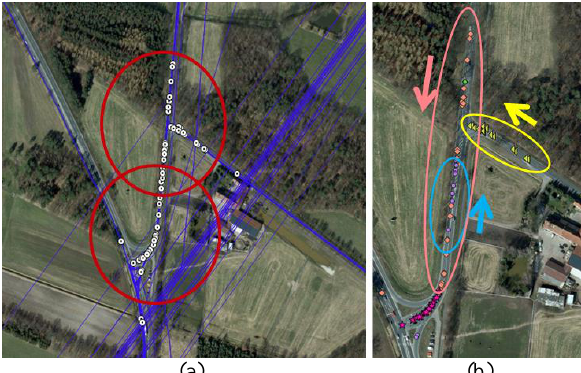
Figure 6. Clusters of stop events as detected with methods 1, 2